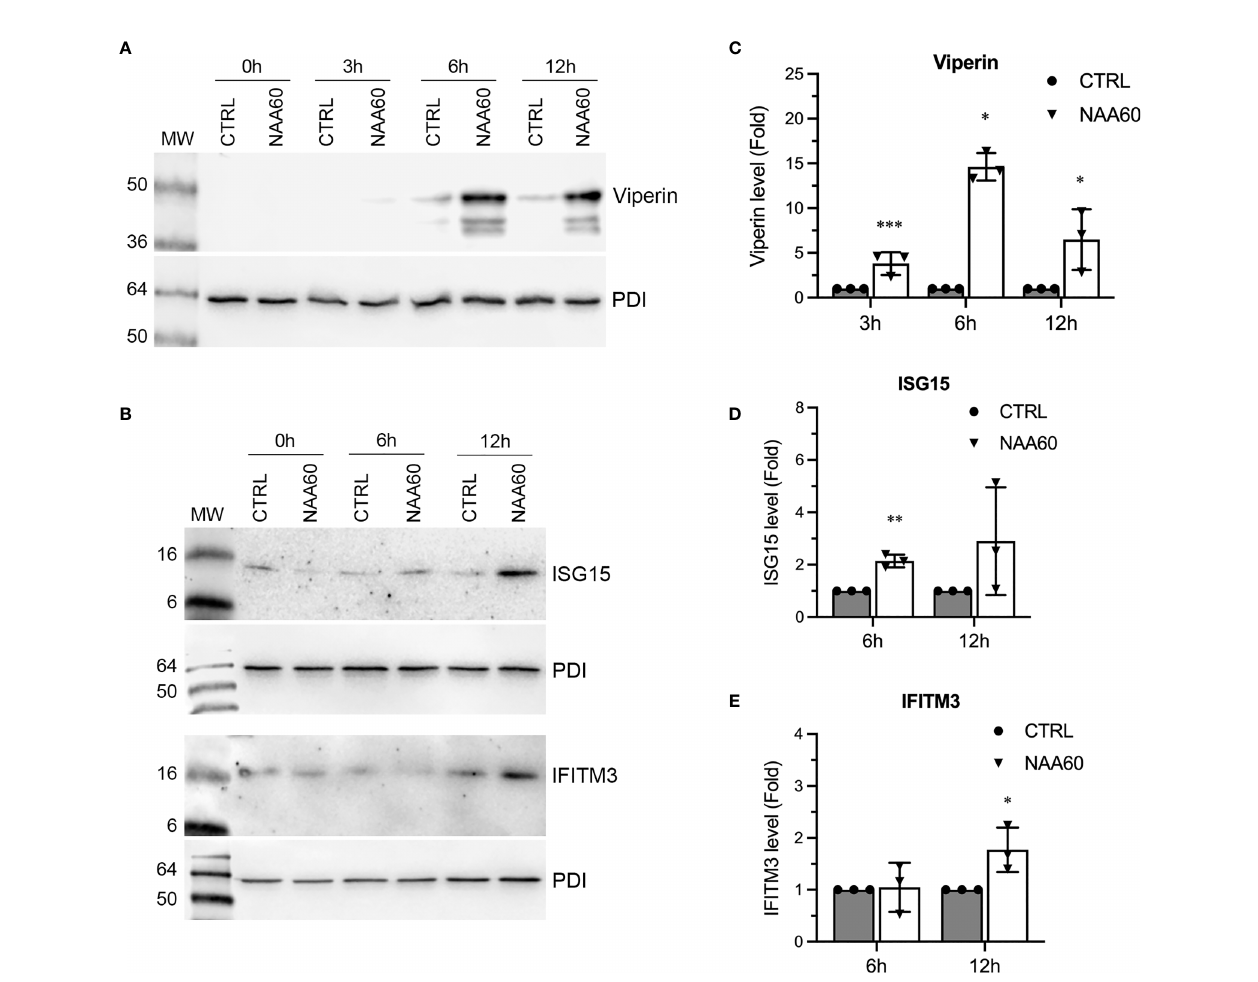
FIGURE 8 | The depletion of NAA60 increases IFN a -induced viperin, IFITM3, and ISG15 polypeptide levels. A549 cells were transfected with 10 nM of CTRL or NAA60 siRNA for 72 h. One set of the cells was processed to con fi rm the depletion of NAA60 by RT-qPCR as in Figure 1A (not shown). The other set of the cells was treated with IFN a at 10 IU/ml for 0 h, 3 h, 6 h, or 12 h, and the cells were processed to detect the viperin (A) , IFITM3 and ISG15 (B) and PDI polypeptide levels by western blotting. The intensity of viperin, IFITM3 and PDI bands was quanti fi ed and normalised with the intensity of corresponding PDI bands. The normalized values of viperin (C) , ISG15 (D) and IFITM3 (E) in CTRL siRNA transfected cells at indicated timepoints were considered 1-fold to determine their amounts in NAA60 siRNA transfected cells at respective timepoints. Error bars represent means ± standard deviation of at least three biological replicates; **P ≤ 0.01, *P ≤ 0.05. MW, molecular weight; Grey bar, CTRL; White bar,